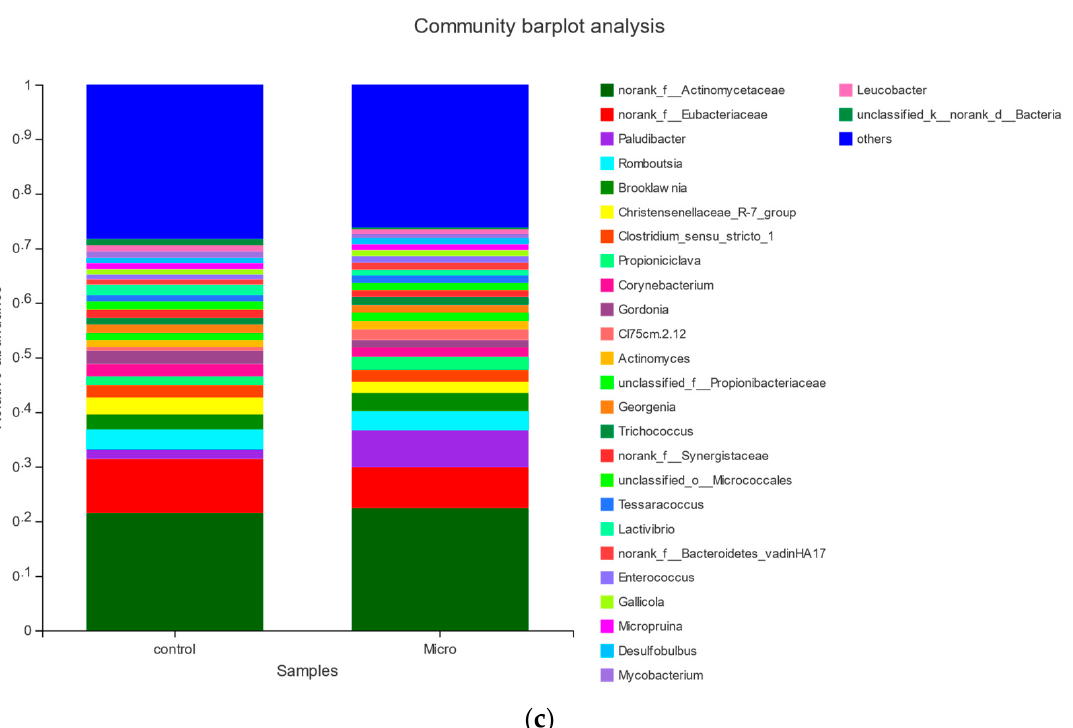
Figure 8. ( a ) Bacterial community phylum-level relative abundance; ( b ) bacterial community class- level relative abundance; ( c ) bacterial community genus-level relative abundance.